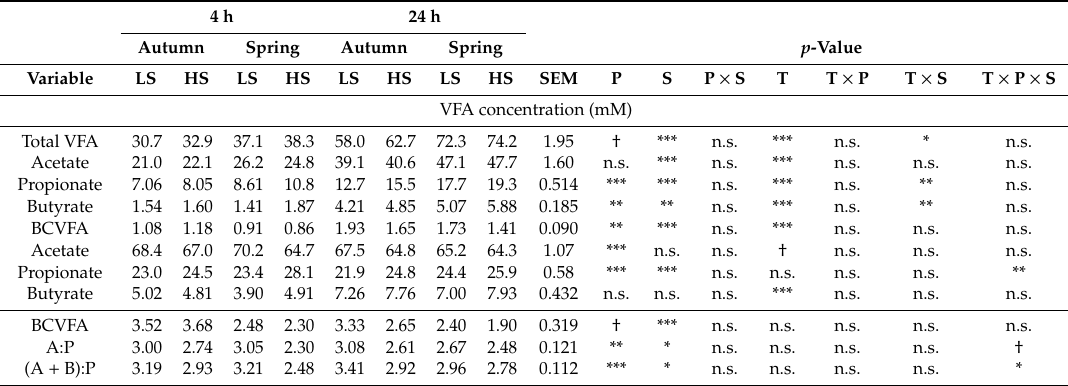
Table 3. E ff ect of pasture type, season, and time on in vitro volatile fatty acids